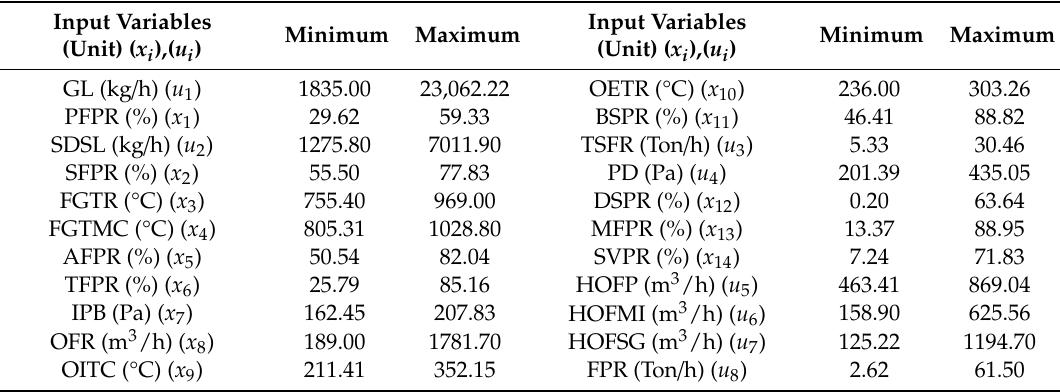
Table 1. List and notations of the inputs.